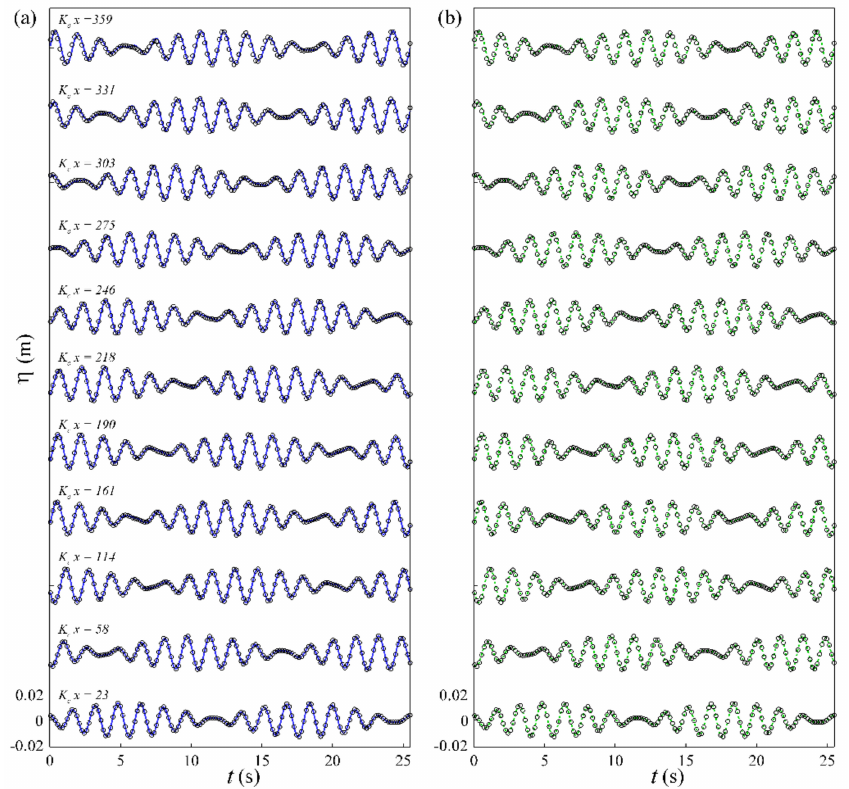
Figure 9. The predicted free-surface displacement time series from the ( a ) FNHS results and ( b ) QNHS results for linear bi-chromatic waves: analytical solutions (circles), FNHS mode (solid lines), and QNHS mode (dashed